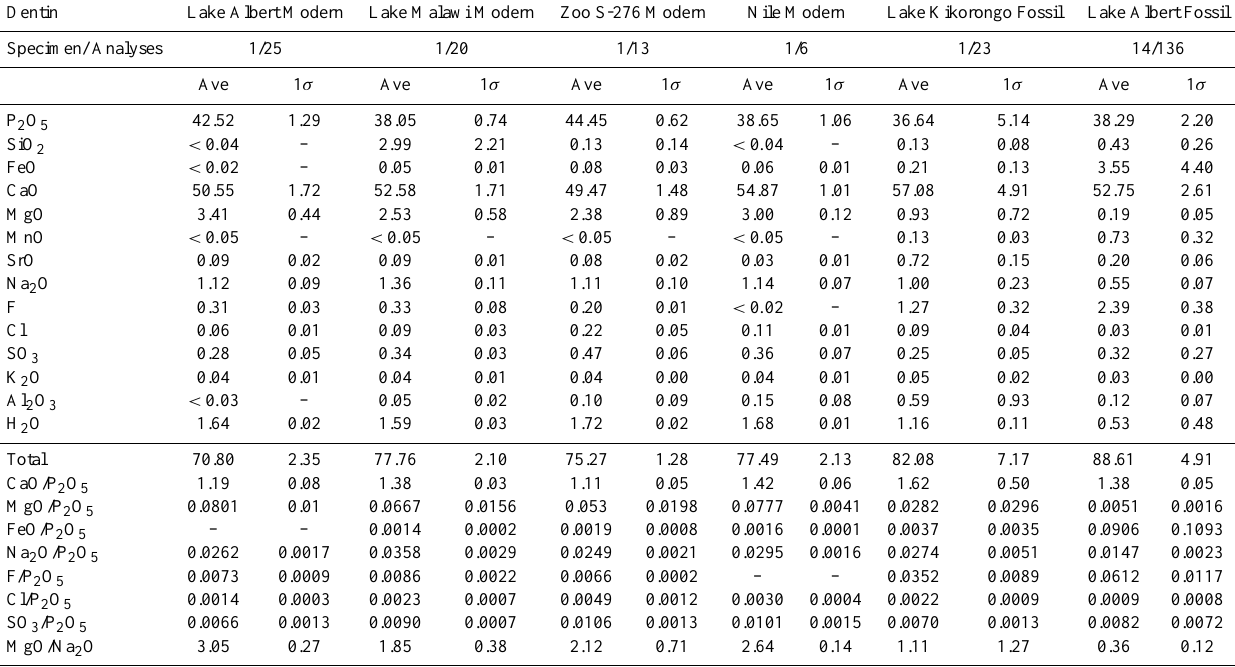
Table 2. Average chemical composition of dentin from modern and fossil hippopotamid molar teeth.